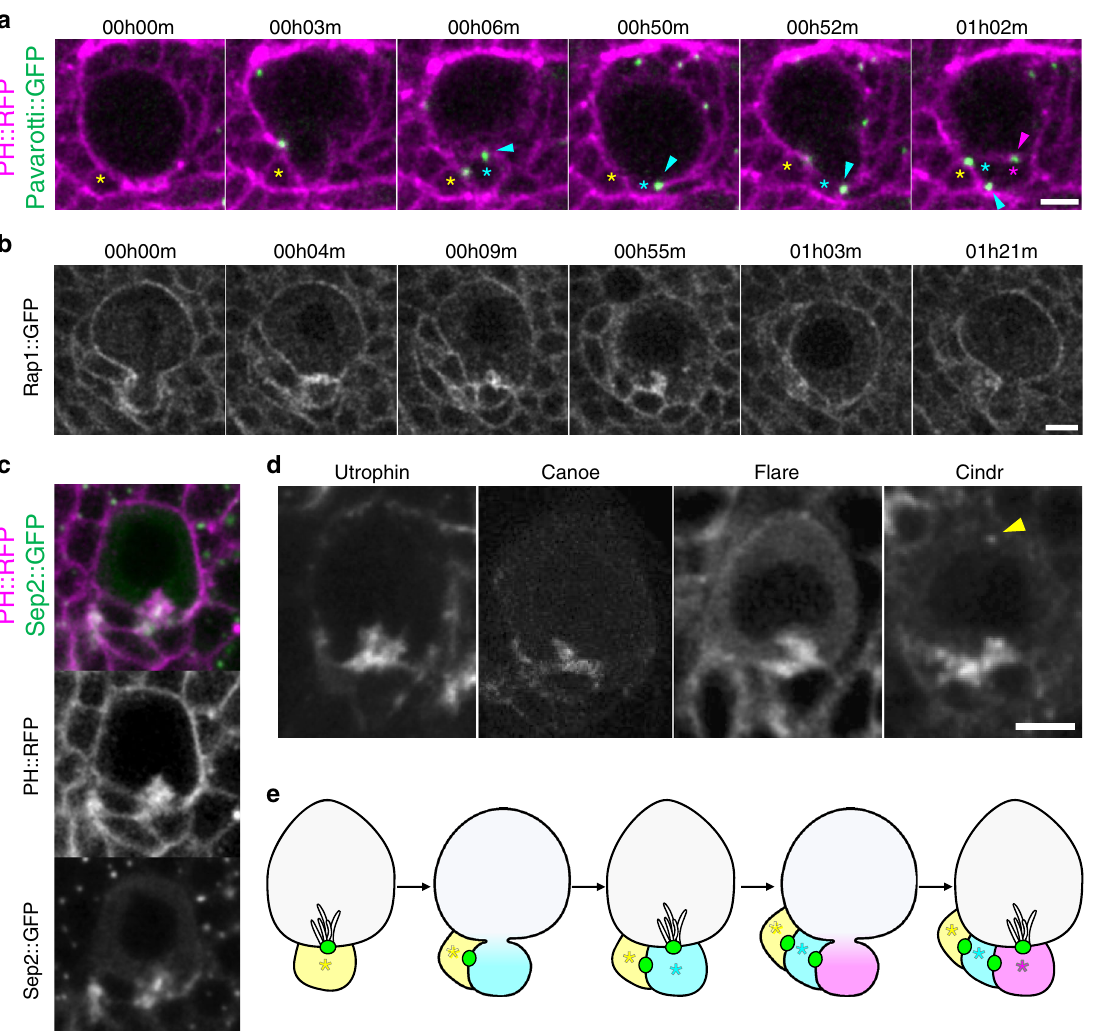
Fig. 4 The NB/GMC interface presents speci fi c characteristics. a Two successive divisions of NBs expressing the membrane marker PH::RFP (magenta) and the midbody marker Pavarotti::GFP (green). Yellow asterisk: previously born GMC, cyan asterisk: GMC formed at subsequent division, magenta asterisks: last-born GMC in this series. Blue arrowhead: midbody formed at the fi rst division recorded stays at the newly formed NB/GMC interface but is inherited by the GMC in the next division, when a new midbody remains at the subsequently formed NB/GMC interphase (magenta arrowhead). b NB expressing the membrane marker Rap1::GFP. Tubular plasma membrane extensions originating from the NB/GMC interface appear within ~ 5 min following closure of the cytokinesis ring (00h04m – 00h09m), persist throughout interphase (00h55m) and disappear upon cell rounding at the onset of mitosis (01h03m). c Interphase NB expressing Sep2::GFP (green) and the membrane marker PH::RFP (magenta). d Interphase NBs expressing GFP or YFP-fusions to the indicated proteins localizing to similar tubular extensions at the NB/last-born GMC interface. Cindr::GFP also localizes to centrosomes (arrowhead). e Schematic illustrating the speci fi c characteristics of the NB/last-born GMC interface and the inheritance of this interface by the GMC at each division. Green: midbody. Asterisk: GMCs, same colour code as Fig. 3a. Scale bar in all panels: 5 µ